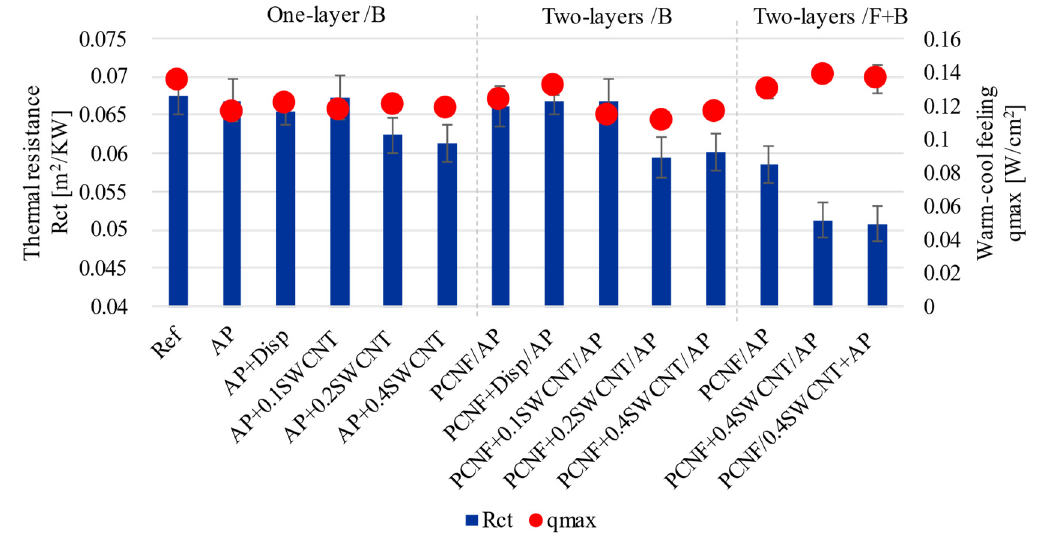
Figure 5. The effect of printing on the fabric’s thermal resistance and corresponding cold-warm feeling, conducted from the front/F side (being in contact with the skin) at 35 ± 1 °C.